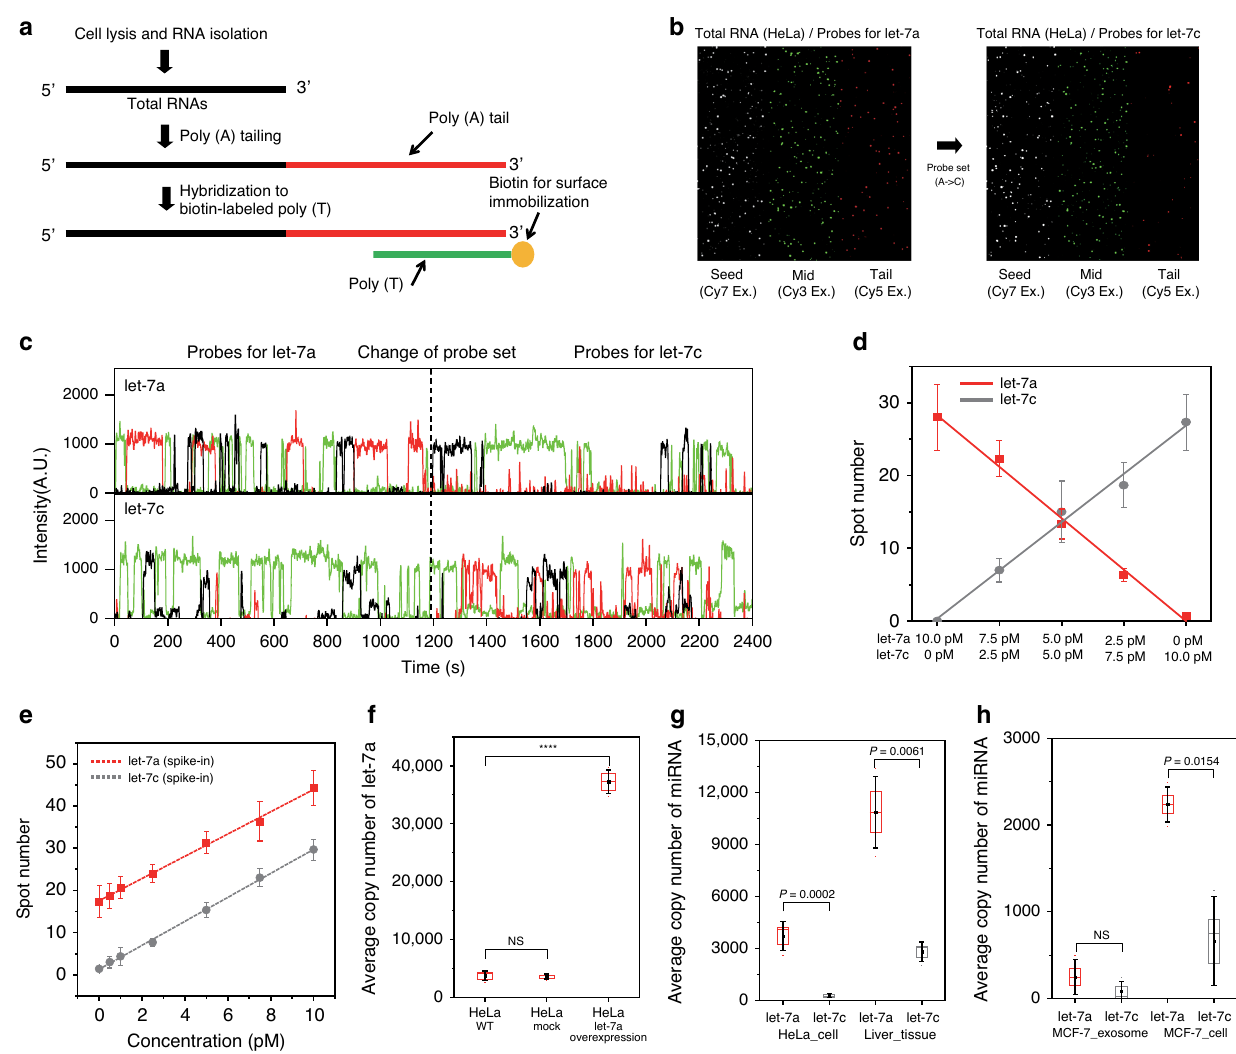
Fig. 3 Quanti fi cation of endogenous miRNAs. a Scheme to immobilize endogenous miRNAs. Total RNA is puri fi ed from cell lysate, tailed with poly(A) at the 3 ′ -end, hybridized with complementary DNA strands, and immobilized on a surface using streptavidin – biotin interaction. b Single-molecule images of let-7a and let-7c miRNA from HeLa cell. c Sequential detection of endogenous let-7a and let-7c. Representative fl uorescence intensity time traces identi fi ed as let-7a (top) and let-7c (bottom) are shown. Probes for let-7a detection were exchanged with probes for let-7c detection at 1200 s (dashed line). d Calibration for miRNA quanti fi cation. The number of spots identi fi ed as let-7a miRNA (red) and let-7c (gray) are plotted at varying combination of concentrations of target RNAs. The data are nicely fi tted to a linear function (solid lines) with zero y -intercept and slopes of 2.8 spot/pM for let-7a and 2.7 spot/pM for let-7c ( R 2 = 0.998 for let-7a, and 0.996 for let-7c). e miRNA spike-in experiments. Varying amount of synthetic let-7a and let-7c miRNAs were spiked in total RNA of HeLa Cell, and their spot numbers were plotted as a function of their concentration. The data are nicely fi tted to a linear function (solid lines) with the same slope (2.8 spot/pM), but different y -intercepts ( R 2 = 0.996 for let-7a, and 0.999 for let-7c). f let-7a detection in HeLa cell, let-7a overexpression HeLa cell, and mock HeLa cell. g Comparison of average copy numbers of let-7a and let-7c per 20 pg total RNA from HeLa cell, and human liver tissue. h Comparison of average copy numbers of let-7a and let-7c per 20 pg total RNA from MCF-7 exosome, and MCF-7 cell. To obtain each data point of d – h , three or more independent experiments were conducted. Data are mean ± SD. P values were determined by two-sided t test (**** P < 0.0001). Source data are available in the Source data fi